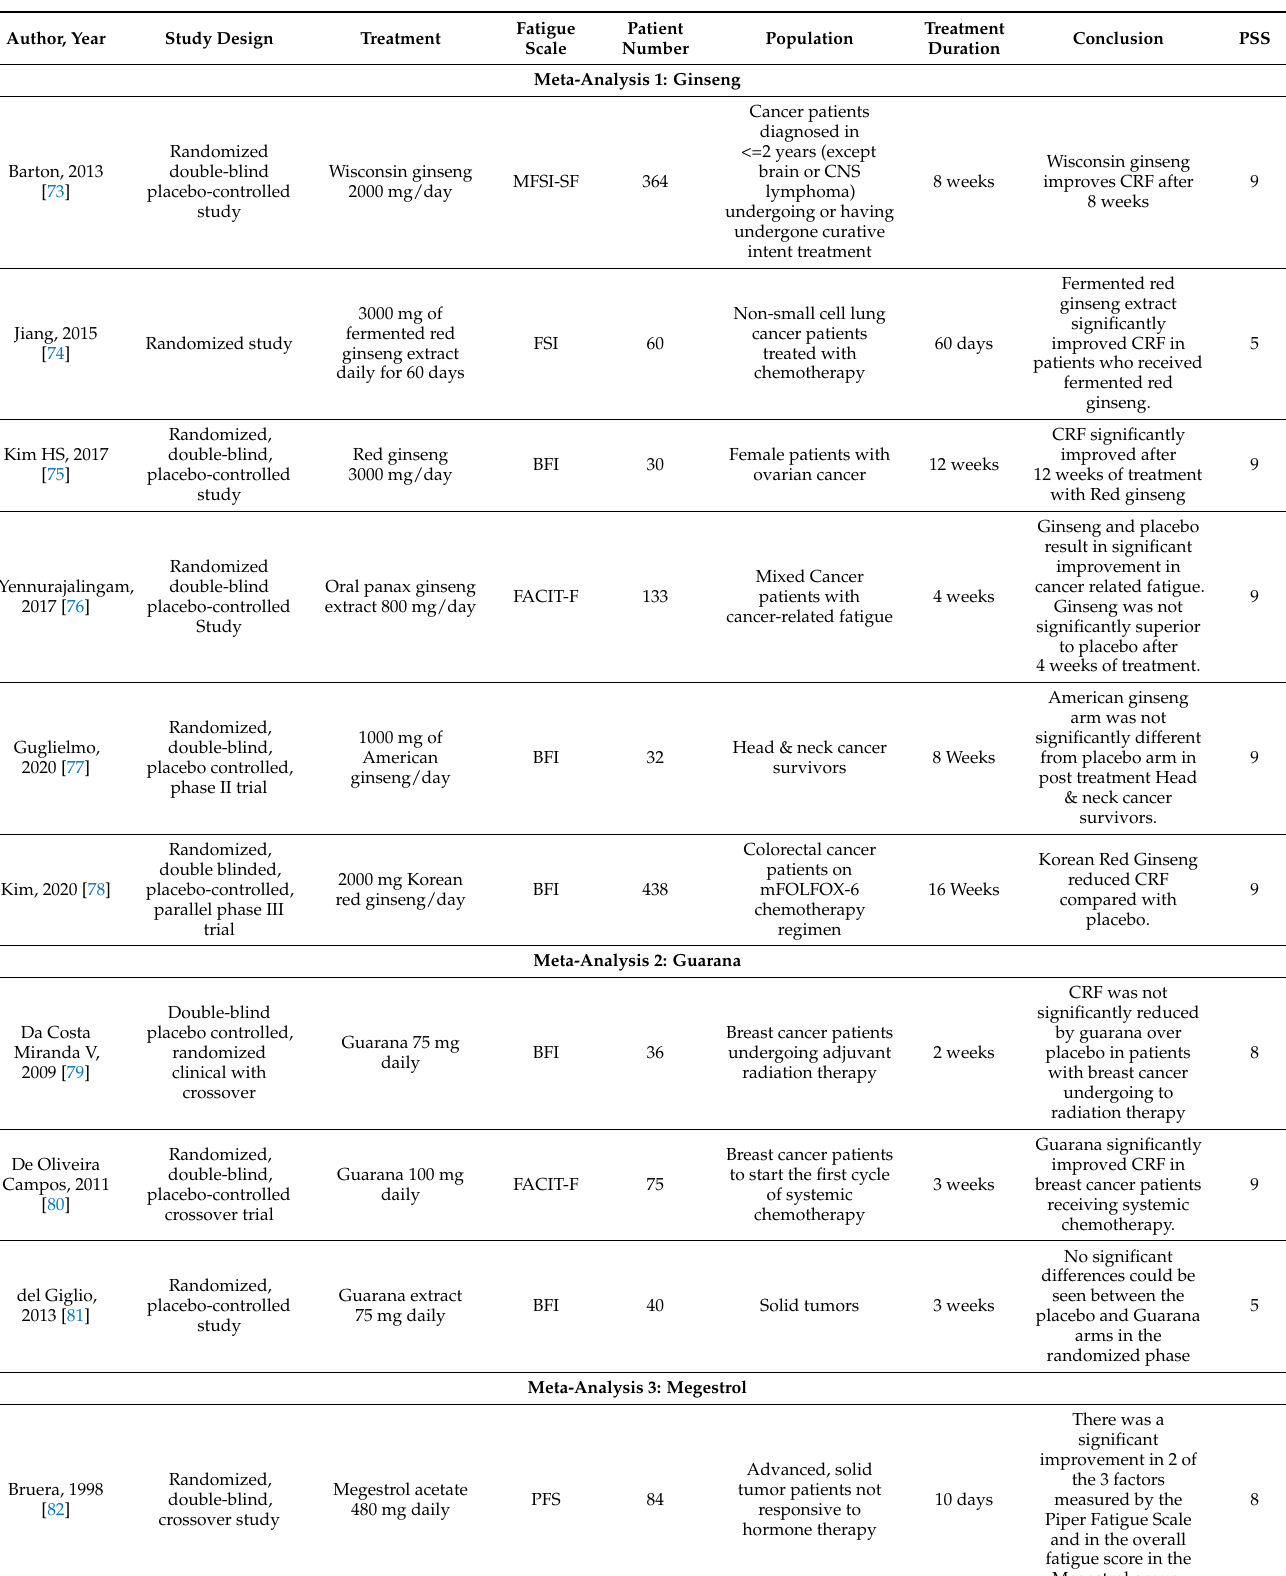
Table 1. Published Cancer Related Fatigue Pharmacological, Nutraceutical and Phyto Pharmaceuti- cals for Treatment Trials and Relevant